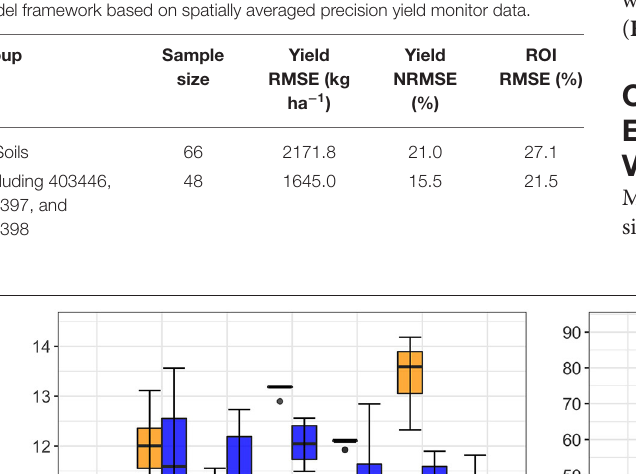
Frontiers in Sustainable Food Systems |